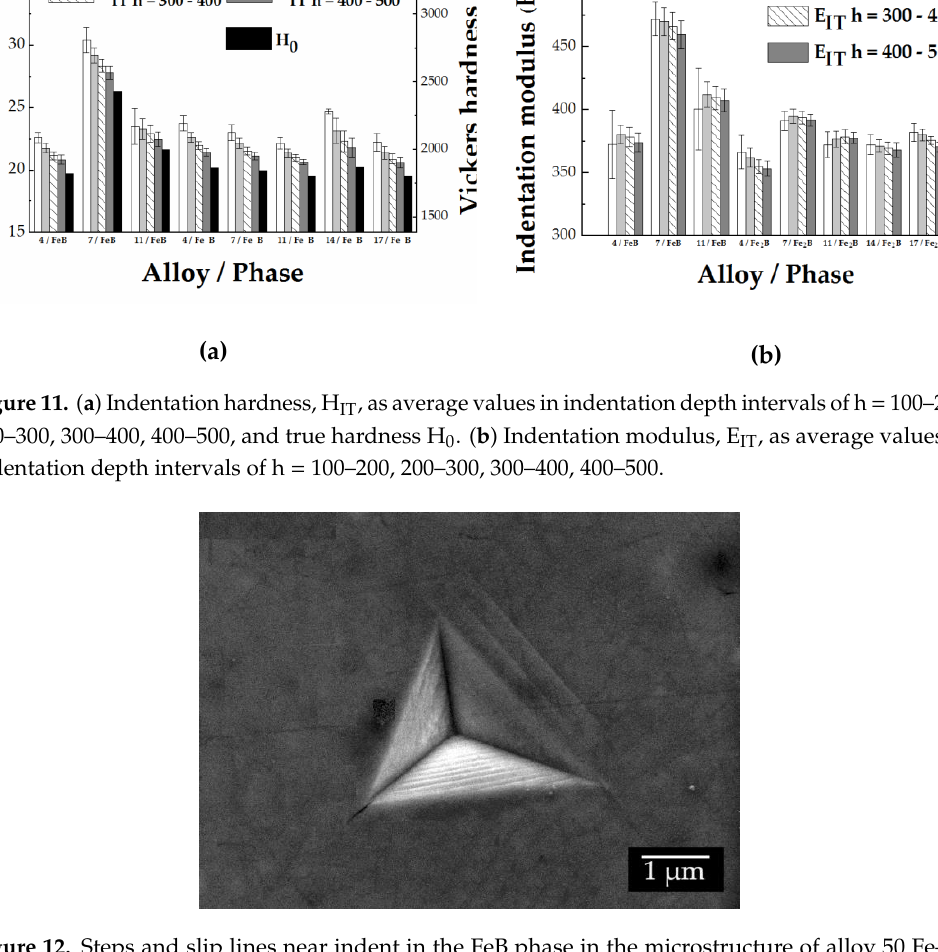
Figure 11. ( a ) Indentation hardness, H IT , as average values in indentation depth intervals of h = 100–